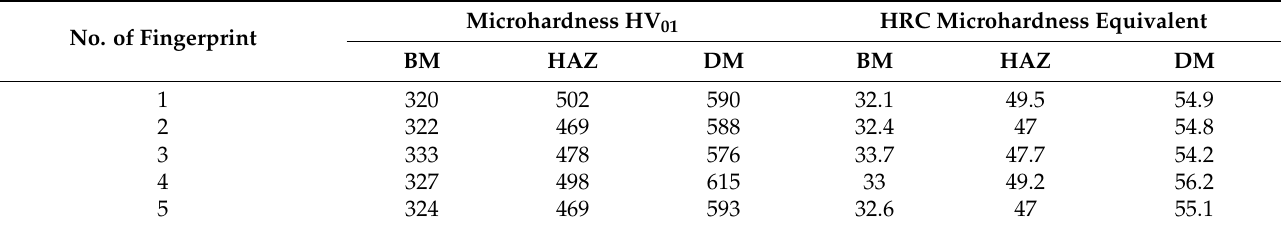
Table 1. The microhardness determinations in the characteristic areas.